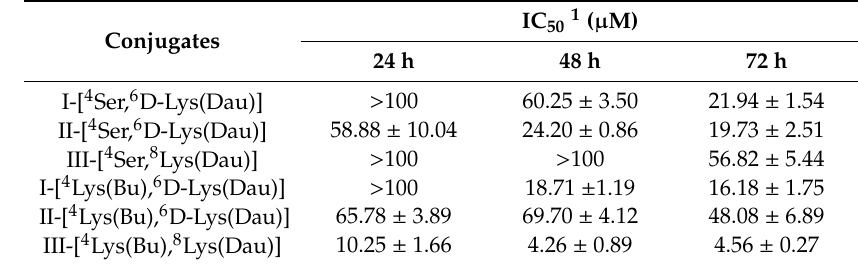
Table 2. IC 50 values of cytotoxicity of Dau–GnRH–[ 4 Ser / 4 Lys(Bu)] conjugates determined on HT-29 cell